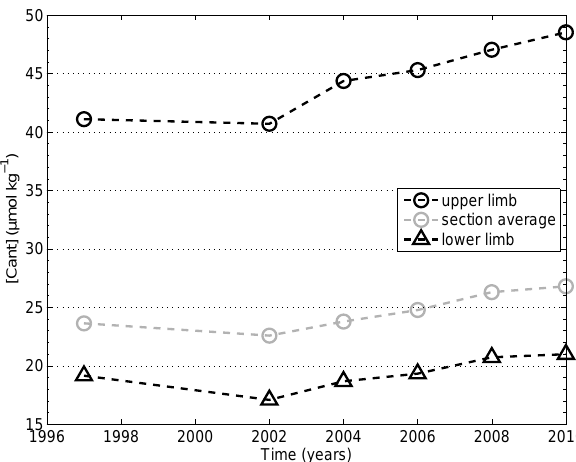
Fig. 7. Time evolution of Cant concentrations: upper limb of the MOC σ (empty black circles), section average value (empty grey circles), and lower limb of the MOC σ (empty black